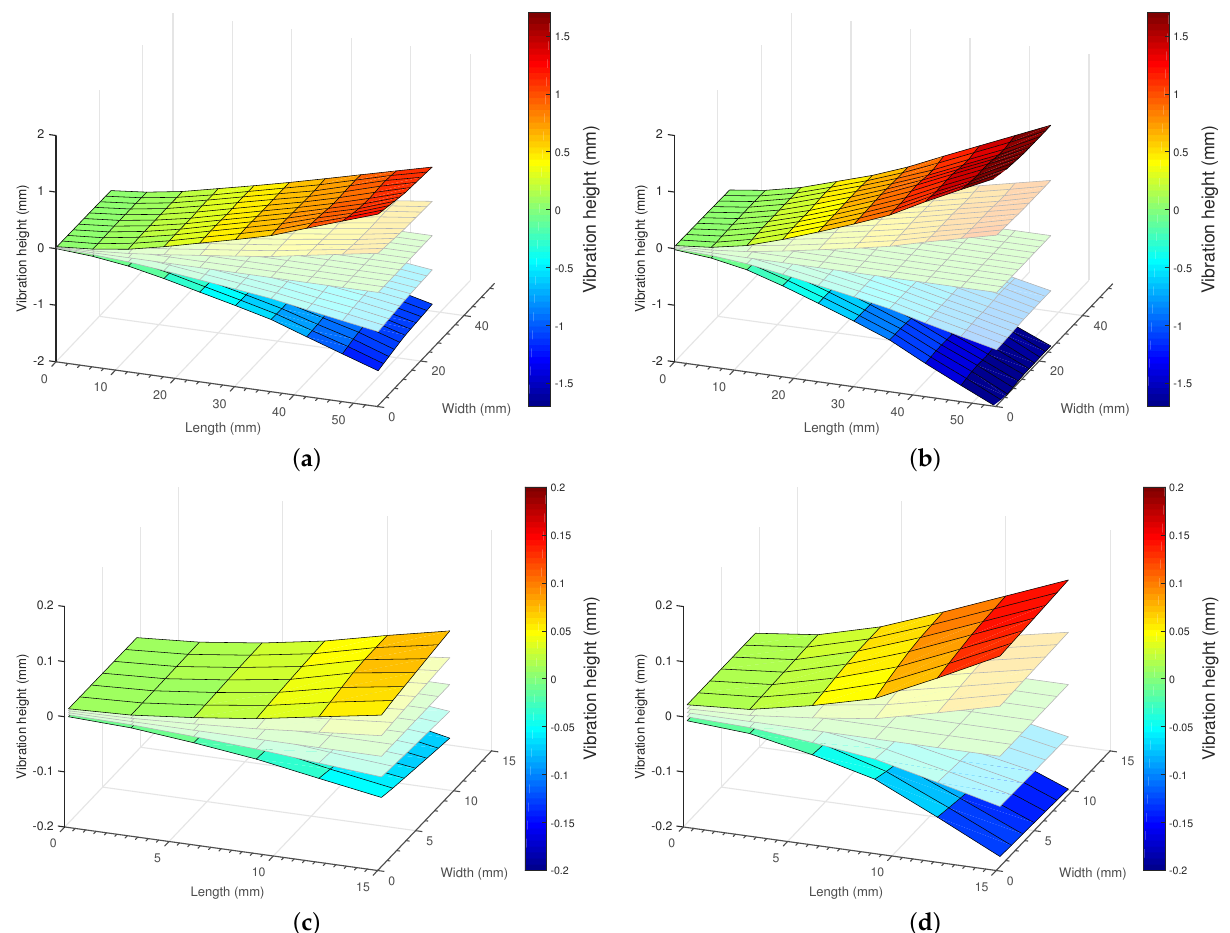
Figure 5. The confirmed oscillation: the first longitudinal mode in the MIDE PPA-1011 at 1 g TE LDTM-028K at 1 g